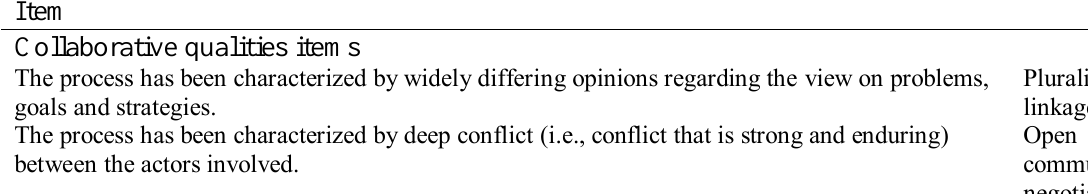
Collaborative qualities items